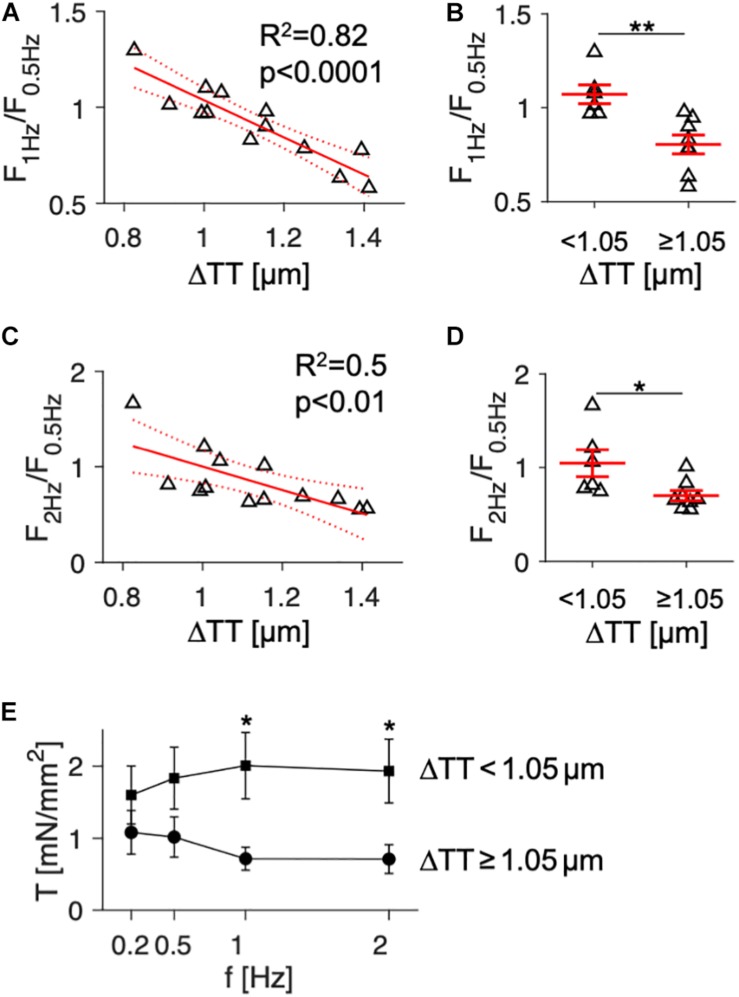
Association of the force-frequency relationship and wall tension with cardiomyocyte t-tubule distance in tissue slices from human failing hearts (n = 13). (A) Linear model showing the correlation of force at 1 Hz relative to force at 0.5 Hz pacing rate (F1Hz/F0.5Hz) with t-tubule distance (ΔTT). R2 is the coefficient of determination, p indicates the probability of type I error of linear regression. Dotted lines indicate 95% confidence intervals. (B) F1Hz/F0.5Hz in specimens with low (<1.05 μm, n = 7) and high ΔTT (≥ 1.05 μm, n = 7). Note that low ΔTT indicates high t-tubule density. (C) Correlation of force at 2 Hz relative to force at 0.5 Hz pacing rate (F2Hz/F0.5Hz) with ΔTT. (D) F2Hz/F0.5Hz in specimens with low and high ΔTT. (E) Mean wall tension (T) developed actively during contraction in specimens with low (squares) and high ΔTT (circles) at 0.2–2 Hz pacing frequency (f). *p < 0.05, **p < 0.01 (unpaired, two-tailed t-test, multiple comparison adjustment in E), error bars indicate SEM.